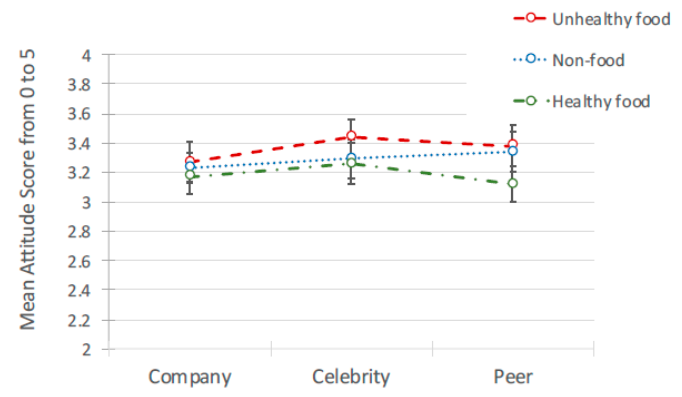
Figure 3. Interaction between Attitude to Peer and source of ad for 3 types of ad.